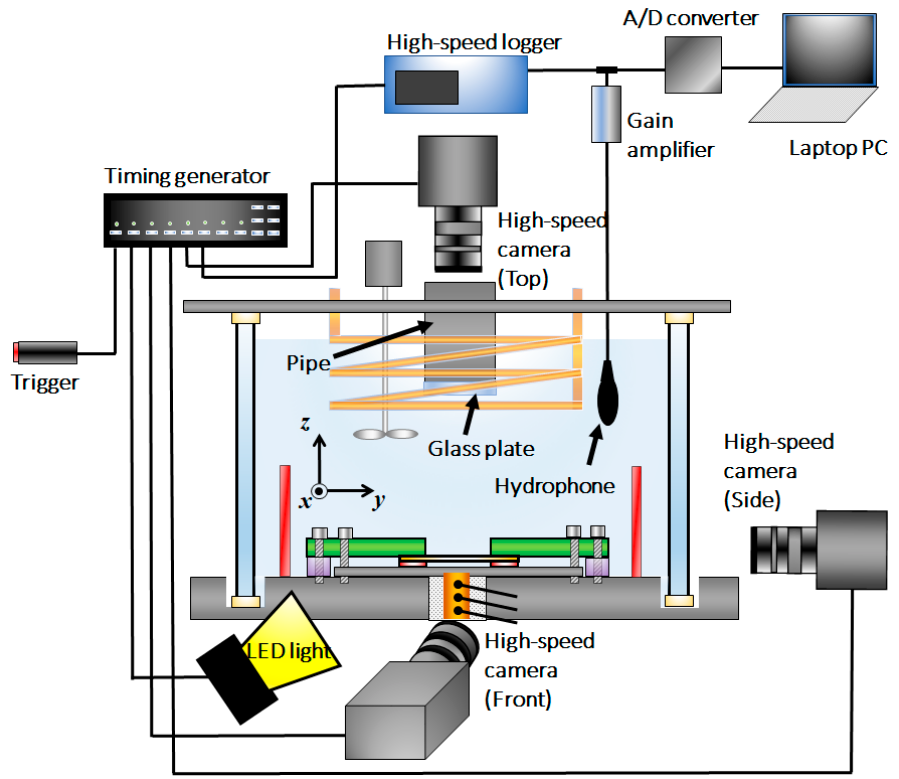
Figure 2. Visualization setup using the synchronized signal with high-speed cameras and a hydro- phone.